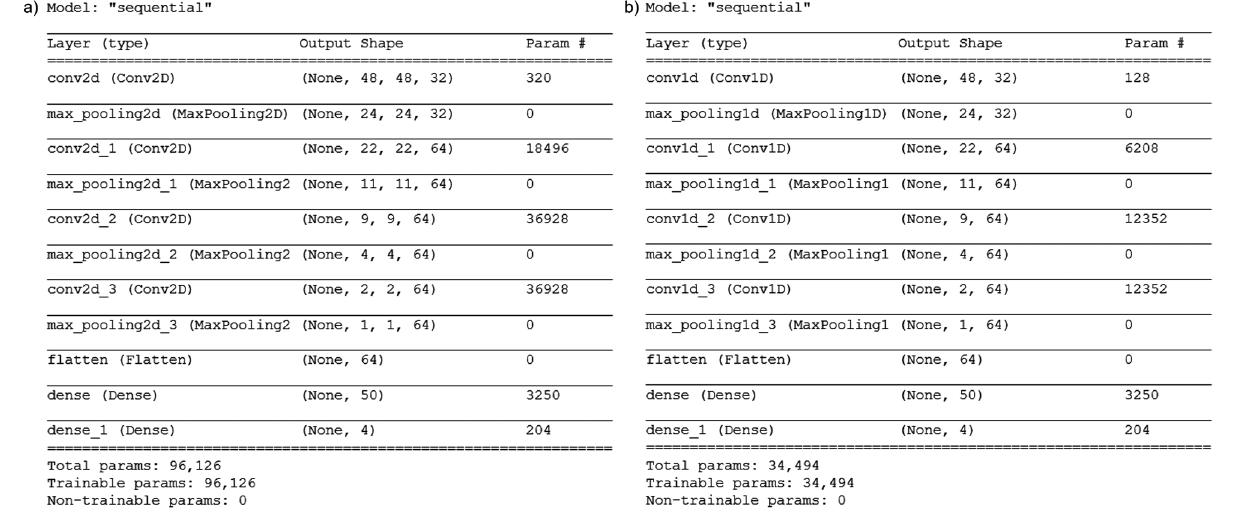
Figure 9. Model architecture of the neural network for 2D microscopy images ( a ) and two orthogonal 1D cross-sections ( b